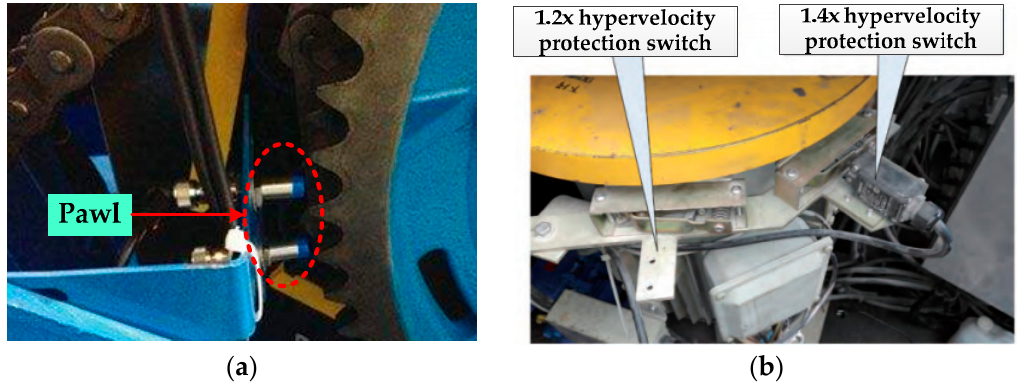
Figure 8. Speed sensors and overspeed protection switch: ( a ) The speed sensors, ( b ) Overspeed protection switch.